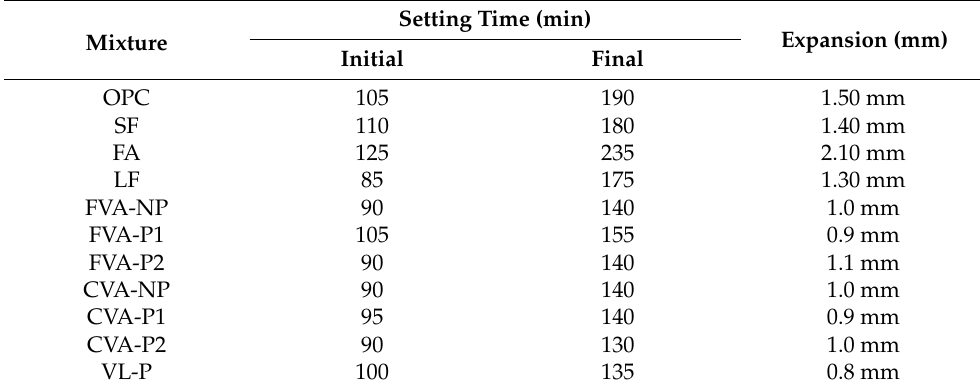
Table 8. Setting time and volumetric expansion of